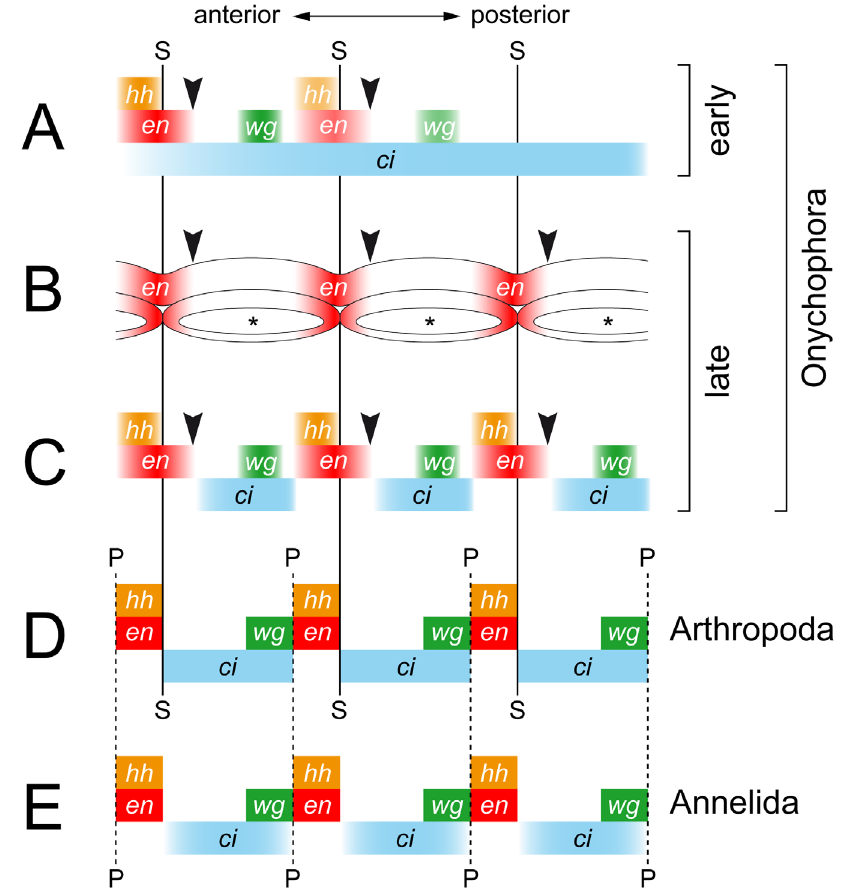
Figure 13. Diagrams comparing the expression patterns of homologs of engrailed , cubitus interruptus , wingless and hedgehog along the body in onychophorans, arthropods and annelids. Vertical lines demarcate the position of segmental (solid lines) and parasegmental boundaries (hatched lines) only for taxa, in which they are identifiable morphologically. Black arrowheads indicate the position of expected, albeit non- existent, segmental boundaries in Onychophora, which is in contrast to arthropods. (A) Diagram of expression in embryos of the onychophoran Euperipatoides rowelli at an early developmental stage. Note the continuous belt of cubitus interruptus expression. (B) Diagram of expression of engrailed in the ectoderm and the mesodermal somites in the onychophoran Euperipatoides kanangrensis (based on previous data [29]). Asterisks indicate coelomic cavities. Note that the expression pattern does not correspond to the segmental boundaries and that each somite shows an anterior and a posterior expression domain. (C) Diagram of expression in embryos of the onychophoran E. rowelli at a late developmental stage. Note the graded expression patterns that do not form distinct boundaries (cf. ref. [29]). (D) Diagram of expression in the fruit fly Drosophila melanogaster , modified from [24]. (E) Diagram of expression in the annelid Platynereis dumerilii , modified from [24]. Abbreviations: ci , cubitus interruptus ; en , engrailed ; hh , hedgehog ; P , parasegmental boundary; S , segmental boundary (in onychophorans only seen during embryogenesis); wg , wingless